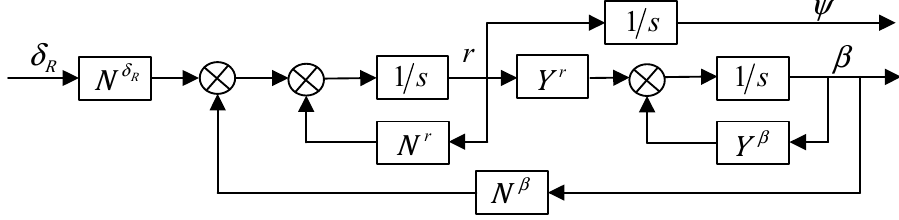
Figure 3. Internal State Structure Diagram of Airship’s Yaw Channel.